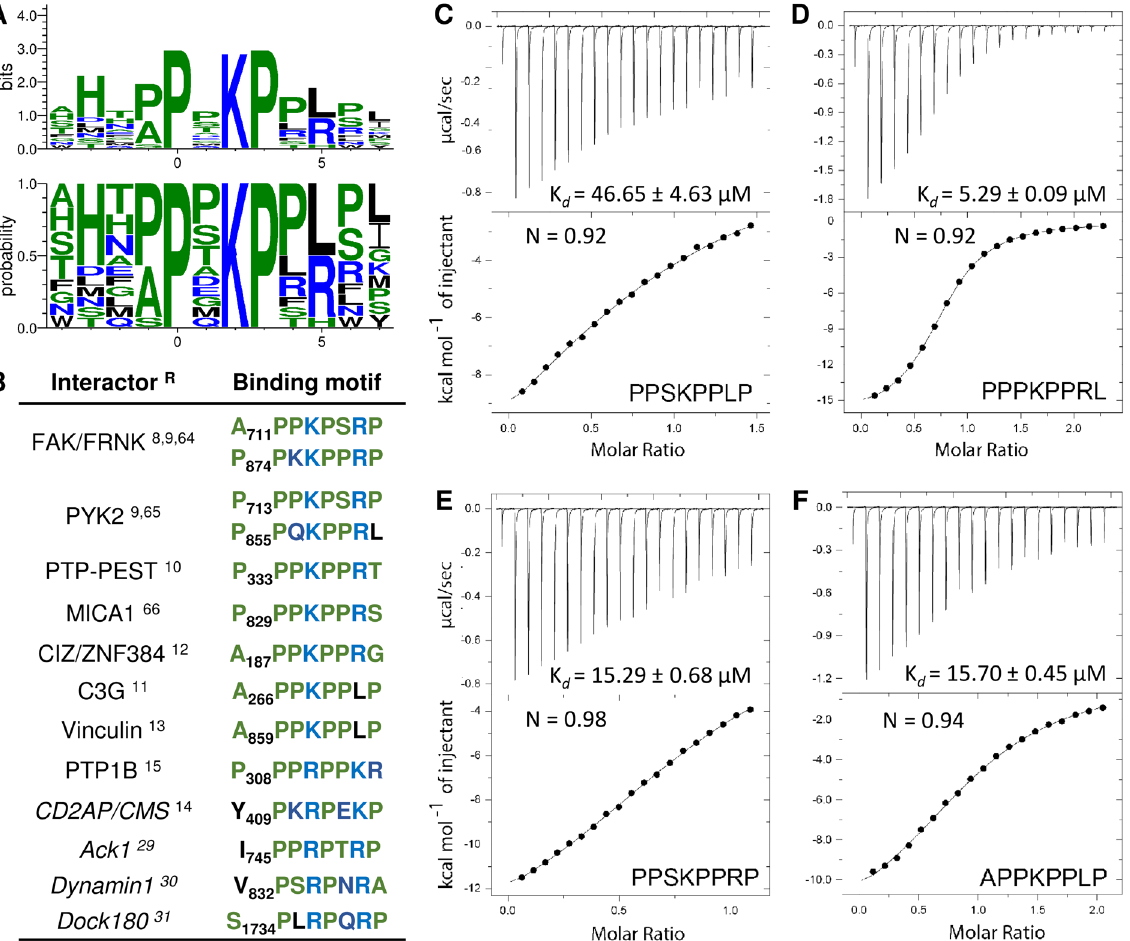
Figure 3. ( A ) The CAS SH3 binding motif based on the 14 unique sequences obtained from phage display. The x-axis shows the residue position relative to proline (position 0) 64–66 . ( B ) The CAS SH3 domain binding interaction partners with their respective binding motifs. Interactors with small differences in binding motif are in italics. References ( R ) are superscripted. ( C – E ) Isothermal titration calorimetry (ITC) data obtained for the interaction of CAS SH3 with four synthetic